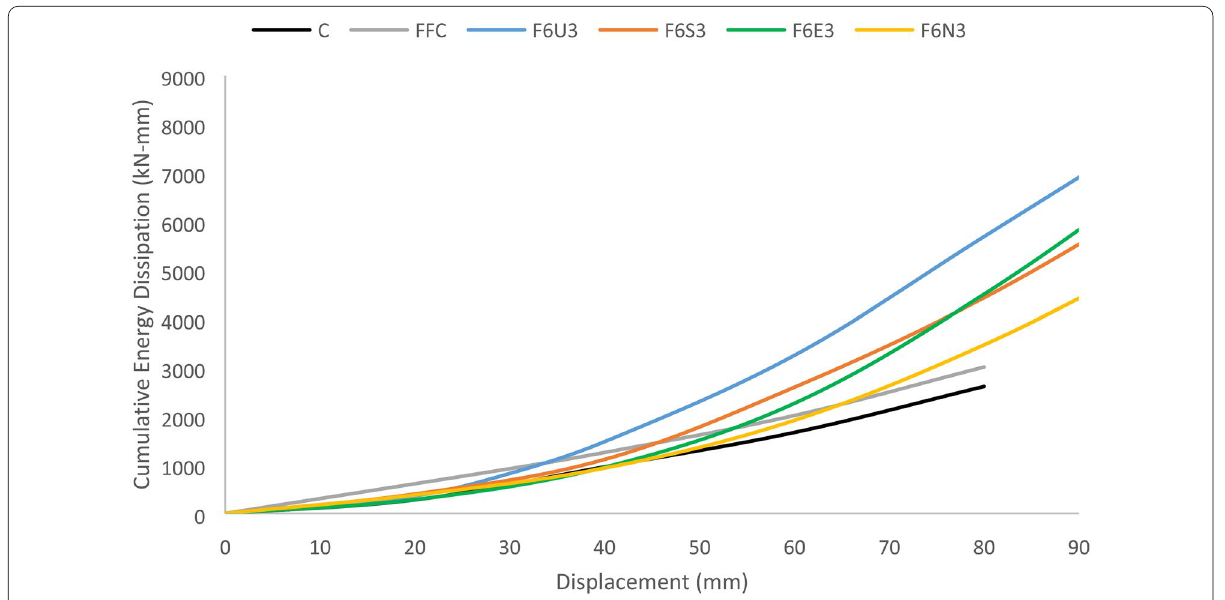
Fig. 17 Cumulative energy